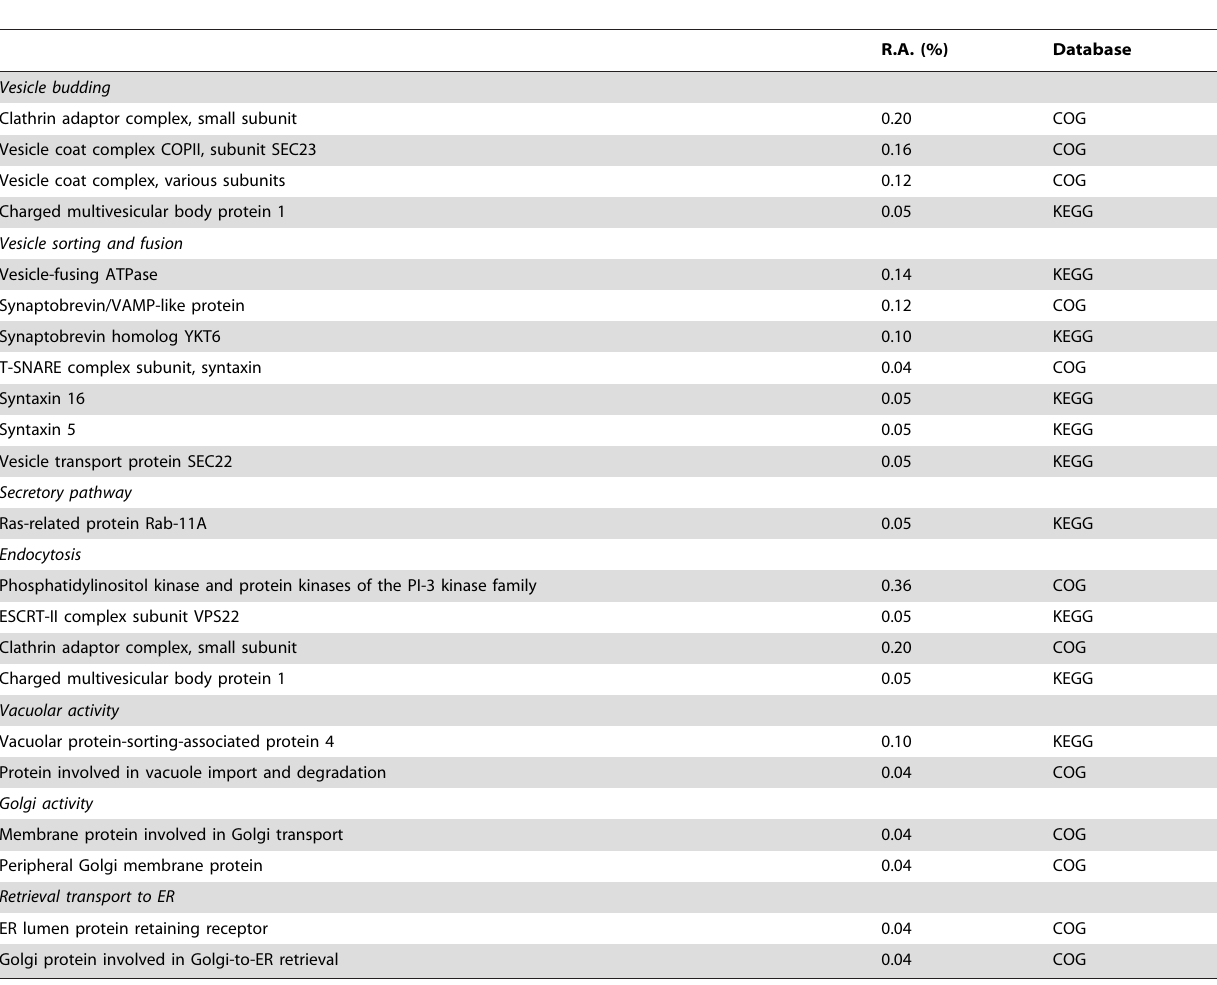
Table 3. Main transcripts related to intracellular trafficking, secretion and vesicular transport in L. dendroidea